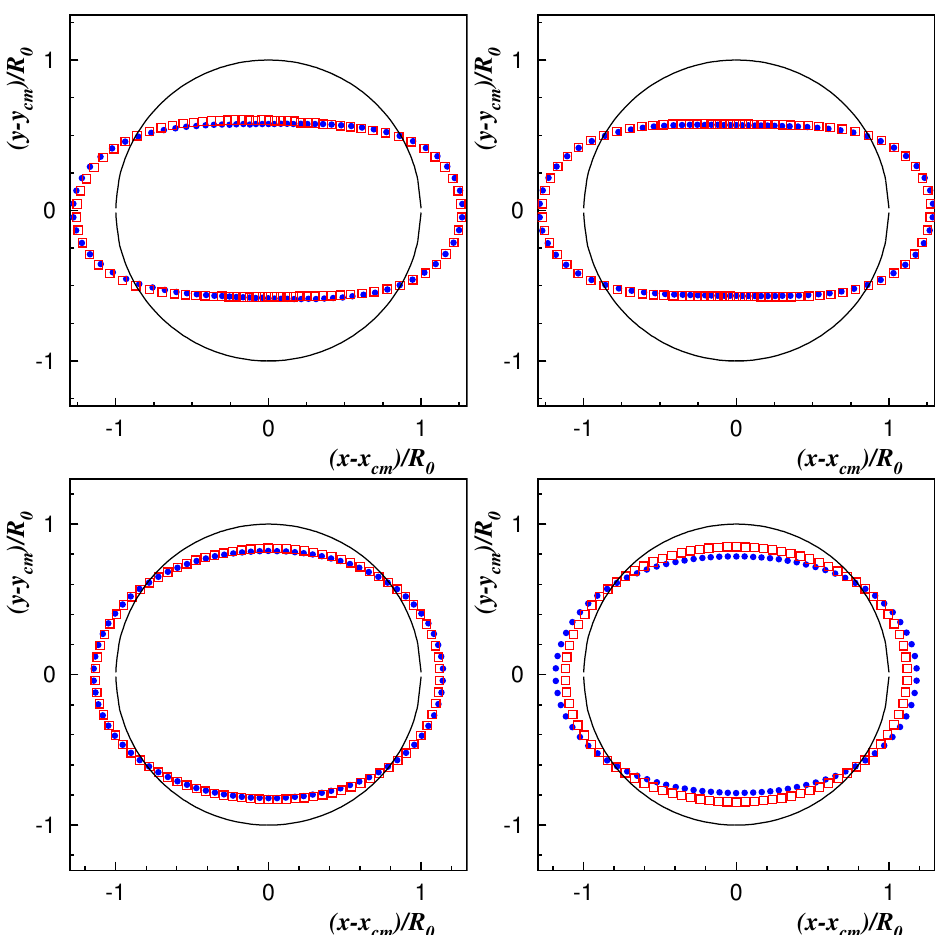
Figure 11. Vesicle average configurations at S ∗ = 0.80 (upper row) and S ∗ = 0.95 (lower row) for κ / ( k B TR 0 ) = 6.58 ( left ), 65.8 ( right ) with λ = 1 ( • ) ,11 ( (cid:3) ) . The full line represents the unit circle as a